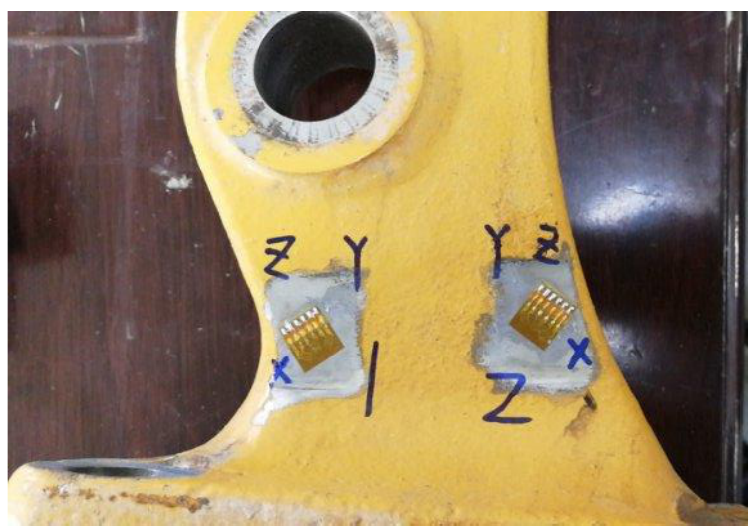
Figure 12. Test points on the steering arm.